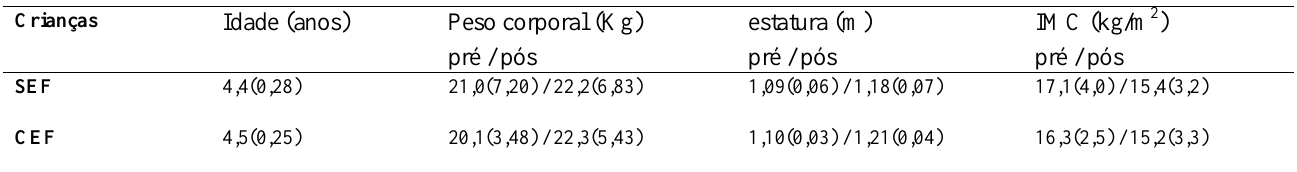
Tabela 1. Média e desvio-padrão da idade cronológica, peso corporal, estatura e índice de massa corporal (IMC) para as crianças sem aulas de educação física (SEF) e com aulas de educação física (CEF), no pré- e pós-teste.